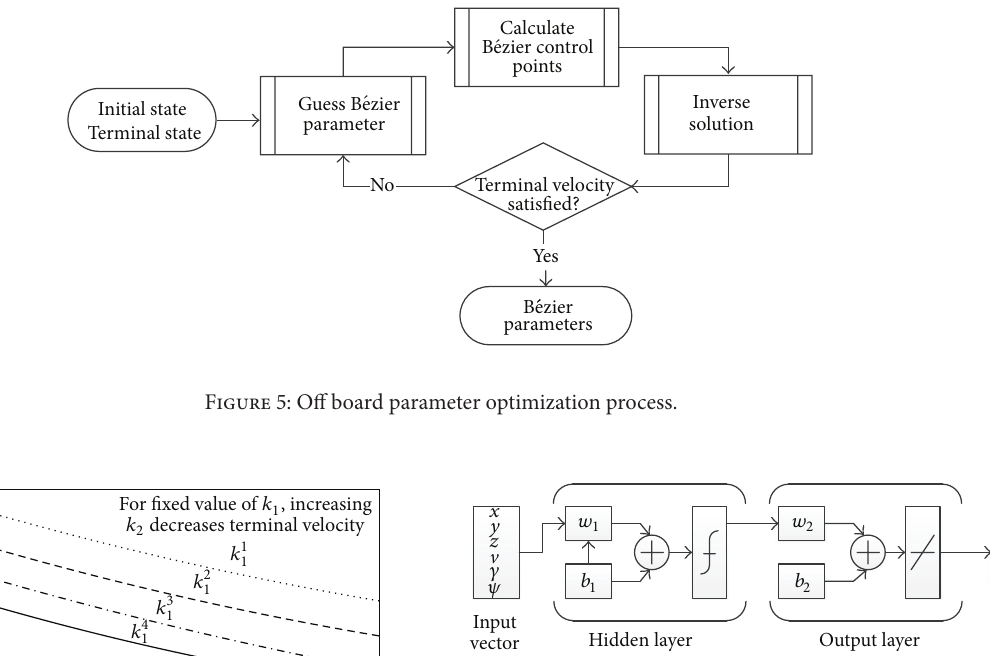
Figure 7: Architecture of feed forward